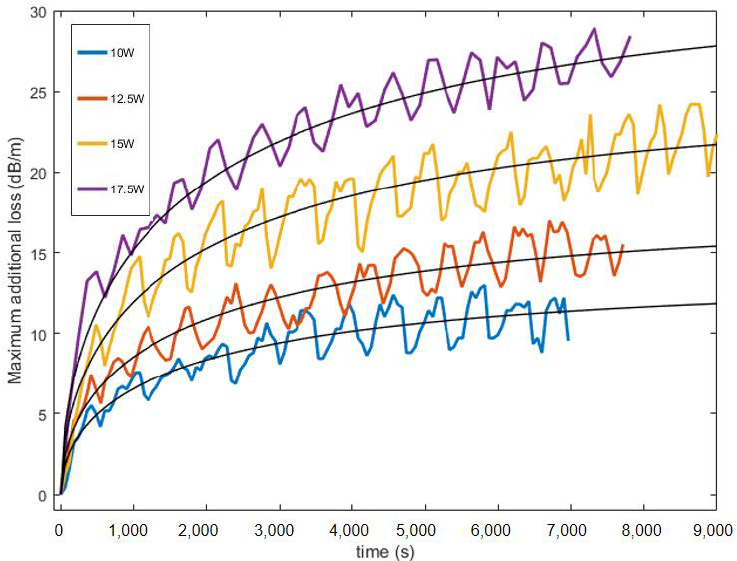
Figure 13. The curve of additional loss with time under different power levels. W hen the β is equal to 0.5396, the calculated 𝛼 𝑃𝐷,𝑚𝑎𝑥 (𝑇) , 𝑊 𝑃𝐷 and R 2 of different pump powers are shown in Table 5.